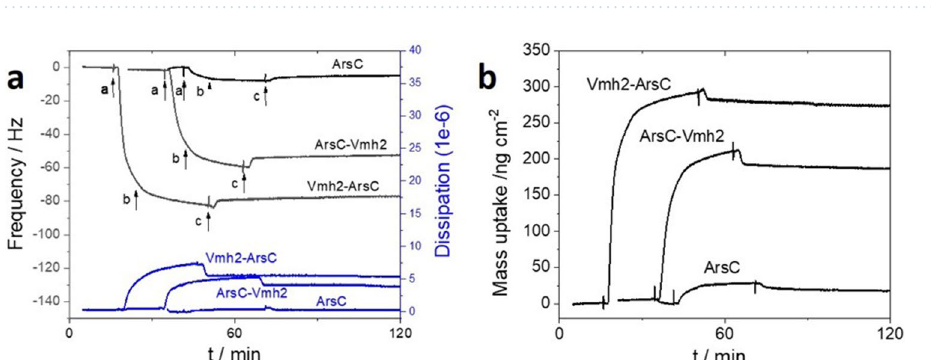
Figure 4. Immobilization on gold. ( a ) QCM-D profile (shifts in resonant frequency (black curve) and in dissipation (blue curve) vs. time) for the immobilization of ArsC-Vmh2, Vmh2-ArsC and ArsC (5th overtone data) before and ( a ) after injection of 0.04 mg mL −1 enzyme solution in Tris–HCl 50 mM, Gu-HCl 0.15 M, DTT 1 mM buffer pH 7.5 for 10 min, ( b ) stop of the flow for 20 min and ( c ) restart of the flow of Tris–HCl buffer; ( b ) Plot of enzyme mass uptake versus time calculated from the Sauerbray Eq. (1) for the 5th